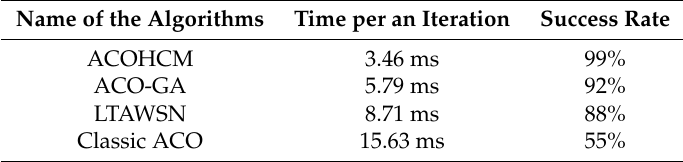
Table 2. Time consumption for iteration and the success rate of searching for the optimal solution of the